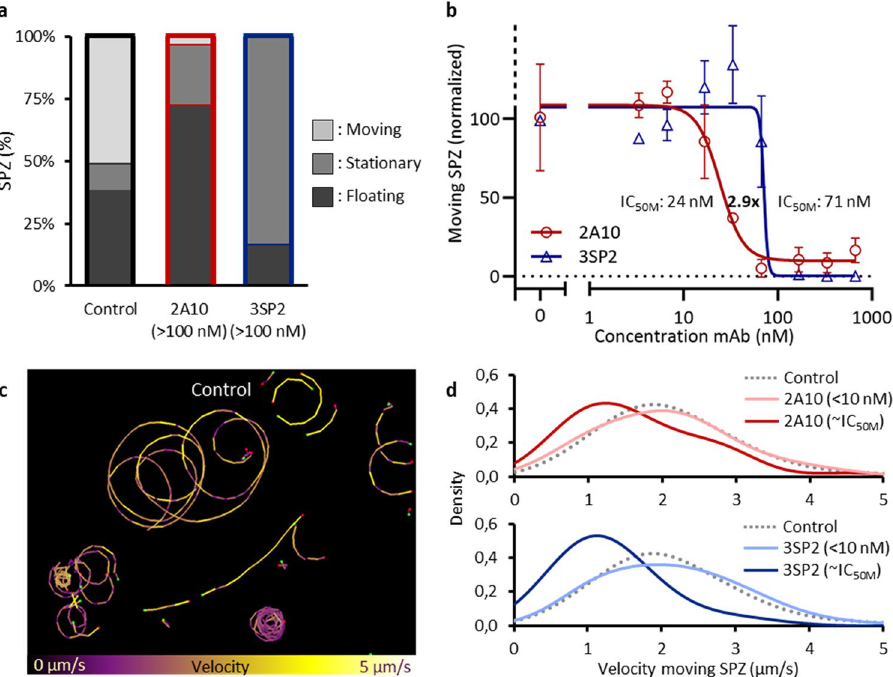
Figure 2. Effect of anti-CSP mAb on SPZ movement and attachment. ( b ) The movement pattern distribution for control SPZ and SPZ exposed to a high concentration (> 100 nM) of the anti-CSP mAbs 2A10 and 3SP2. ( b ) The normalized percentage of moving SPZ plotted against the concentration of mAb to determine the IC 50M value at which movement of SPZ was 50% reduced. ( c ) Tracks of SPZ moving in vitro on a glass surface, color-coded for velocity using color range: purple (low velocity) to yellow (high velocity). ( d ) The probability distribution plotted of the velocity of control SPZ (median: 2.0 (IQR: 1.5–2.6) μm/s), SPZ exposed to low concentrations of 2A10 and 3SP2 (7 nM) (median velocity 2A10: 2.1 (IQR: 1.4–2.6) μm/s, median velocity